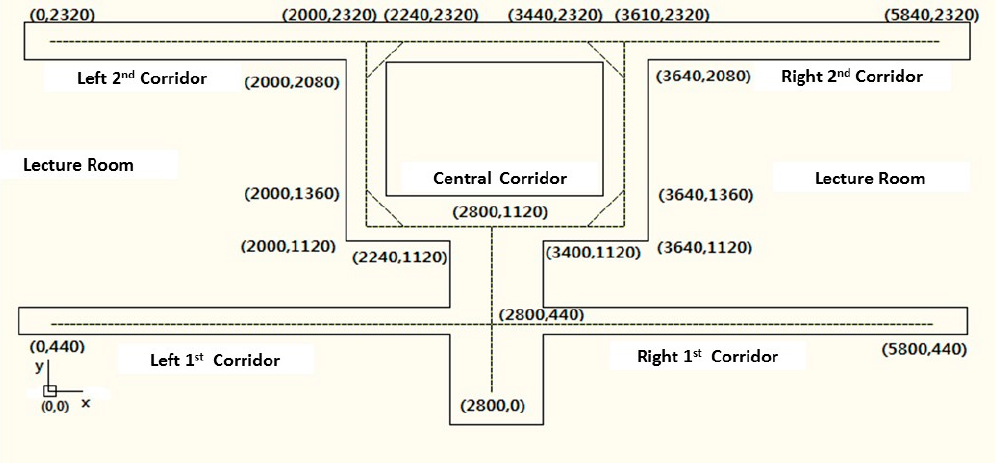
Figure 6. Test floor of small area.